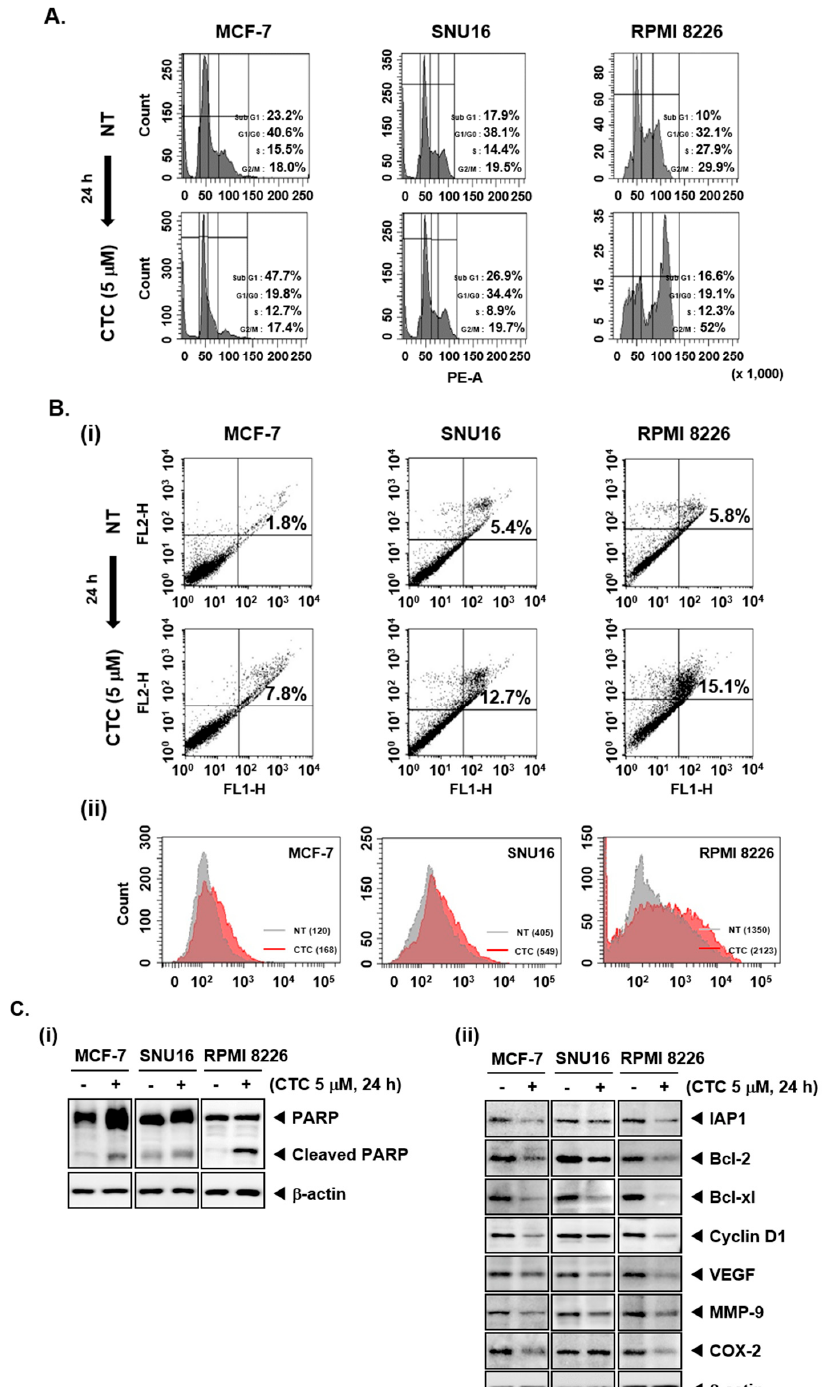
Figure 2. CTC induces apoptosis and reduces expression of Akt/mTOR regulated gene products. ( A ) The cells were treated with 5 µM of CTC for 24 h, harvested, stained with propidium iodide (PI), and analyzed using a flow cytometer. ( B-i ) The cells were treated with 5 µM of CTC for 24 h, harvested, stained with FITC-conjugated anti-Annexin V, and analyzed using a flow cytometer. ( B-ii ) The cells were treated with 5 µM of CTC for 24 h, harvested, fixed, incubated with a TUNEL reaction solution, and analyzed using a flow cytometer. ( C-i , ii ) The cells were treated with 5 µM of CTC for 24 h and western blot analysis was performed as described above in panel 1C. Abbreviation: NT = non-treated.